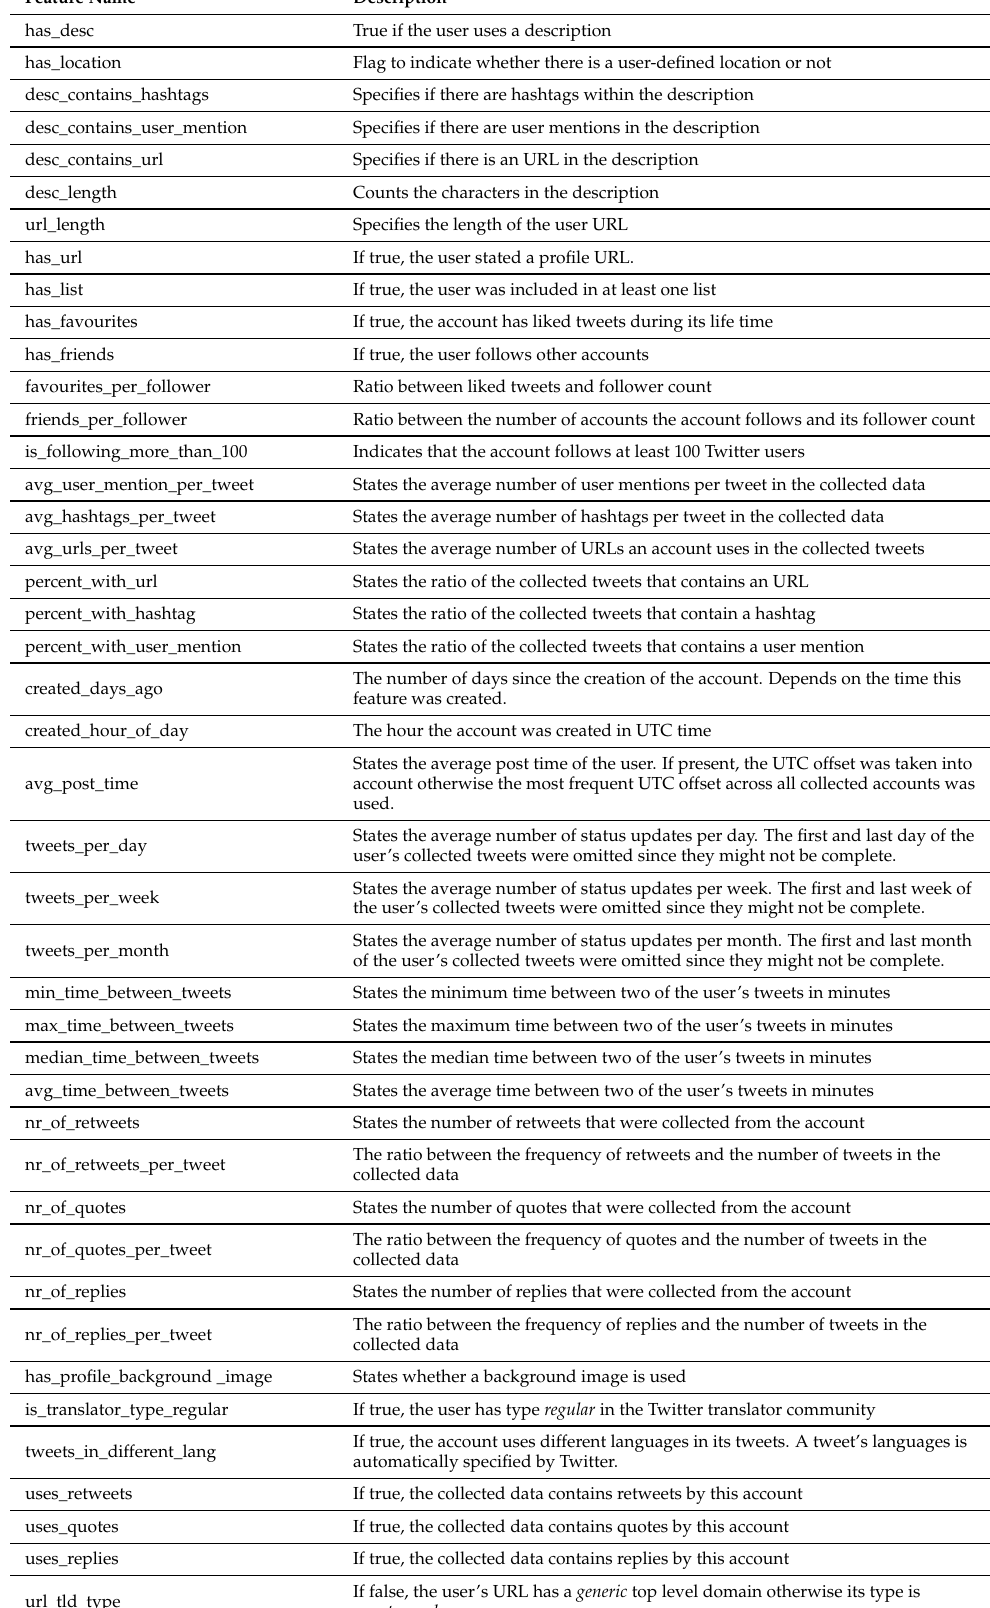
Table A2. Overview of the derived user level